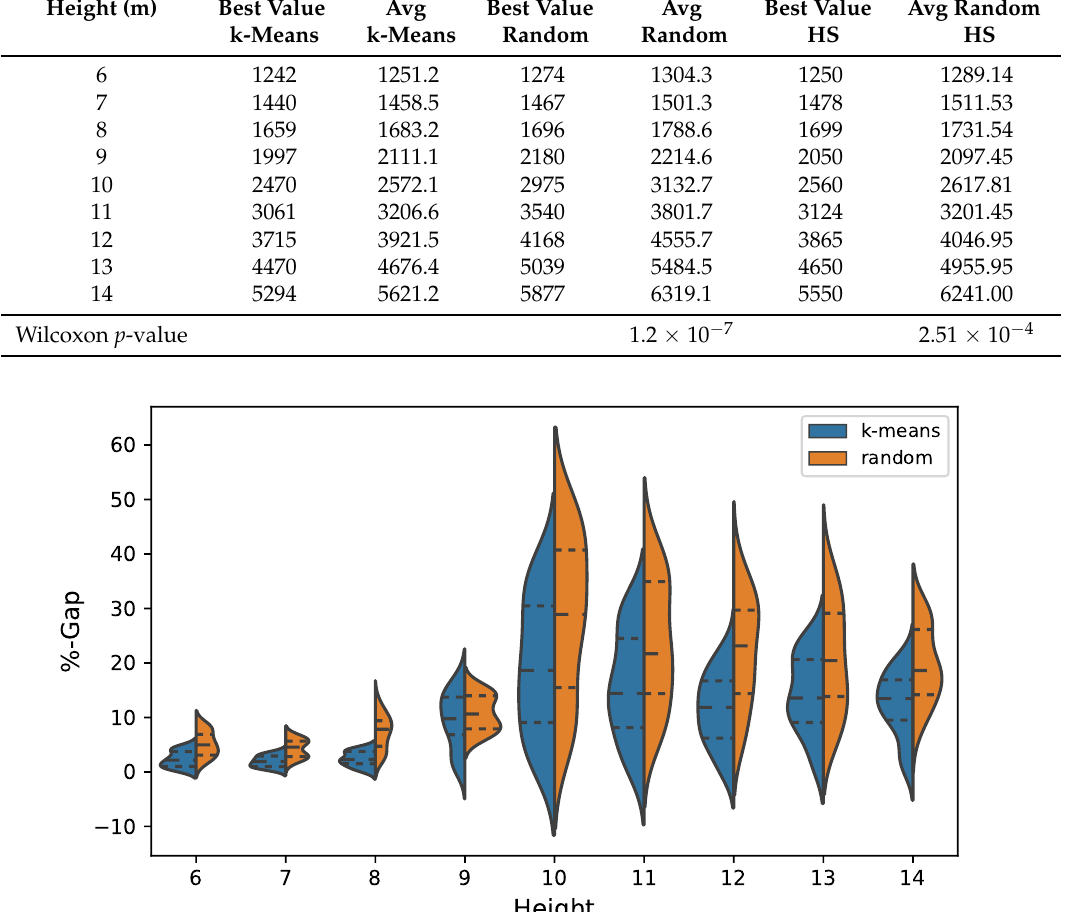
Figure 9. Emission Violin plots, comparison between k-means and random operators. Figure 10a,b show the convergence diagrams for cost optimization for the algorithm using k-means and random, respectively. The heights chosen were 6, 9, 12 and 14. From Figure 10a it